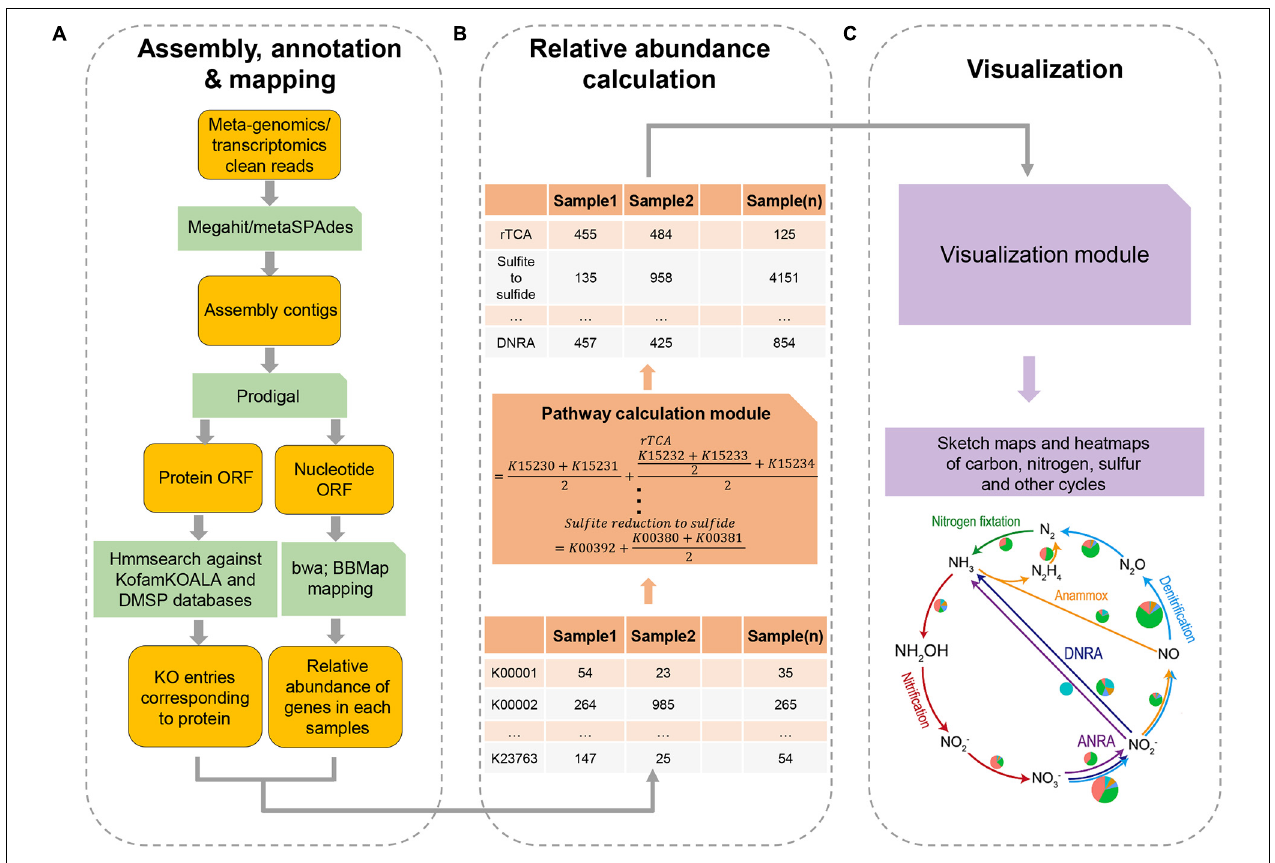
FIGURE 1 | A flowchart of the major steps involved in running DiTing. First (A) , clean reads of metagenomes or/metatranscriptomes are assembled, annotated, and mapped. Second (B) , a table for relative abundances of KO number in KEGG among samples is constructed and relative abundances of biogeochemical pathways are estimated according to unbiased specific formulas. Third (C) , heatmap and sketch plots are drawn to aid